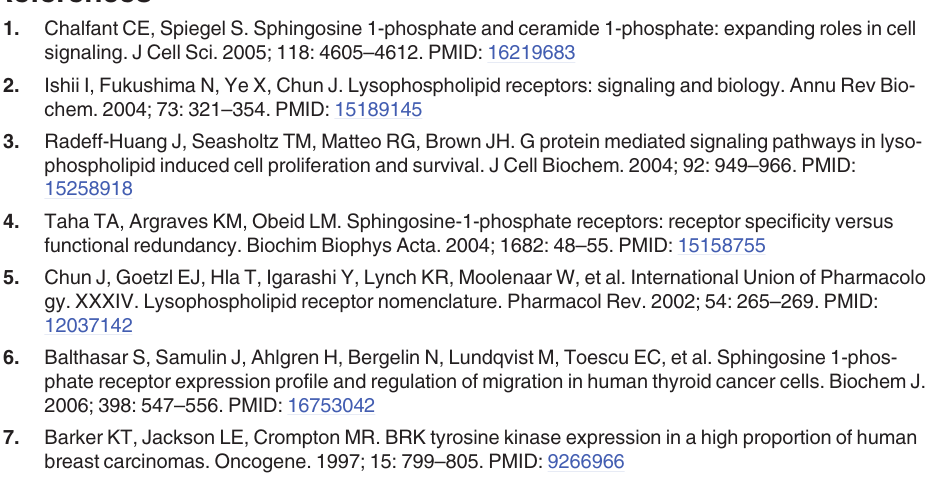
S1 Fig. S1P affects ERK1/2 activation. S2 Fig. Effect of PTK6 and ERK1/2 on S1P-induced migration of FTC-133 cells. S3 Fig. Screening for miRNAs that are involved in the S1P-induced signaling pathway and that target the 3 ’ UTR of PTK6. S4 Fig. miR-17 down-regulates PTK6 expression in FTC-133 cells. S5 Fig. miR-17 inhibits the S1P-induced cell migration through the PTK6-ERK signaling pathway in FTC-133 cells. S6 Fig. Effect of miR-17 and PTK6 on S1P-induced ERK phosphorylation. S1 Table. Correlation of PTK6 and miR-17 expression with clinicopathologic features in papillary thyroid cancers (PTC). S2 Table. Primers Used in Quantitative Real-Time RT-PCR. (DOC) S3 Table. The target sequence of PTK6 and ERK